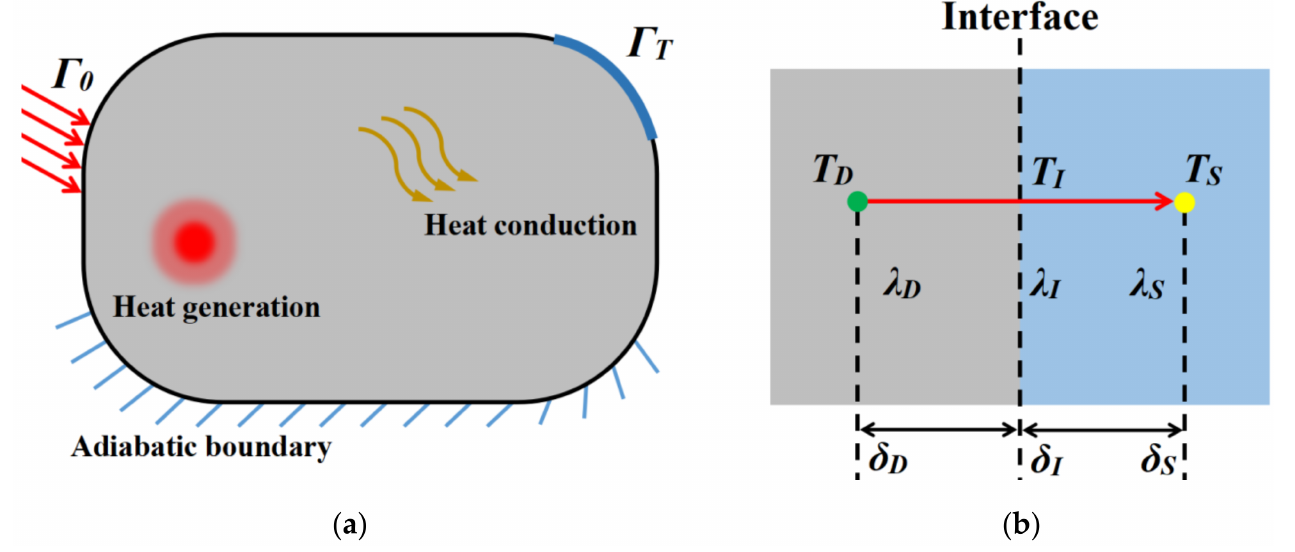
Figure 6. ( a ) General heat conduction. ( b ) Heat conduction of composite